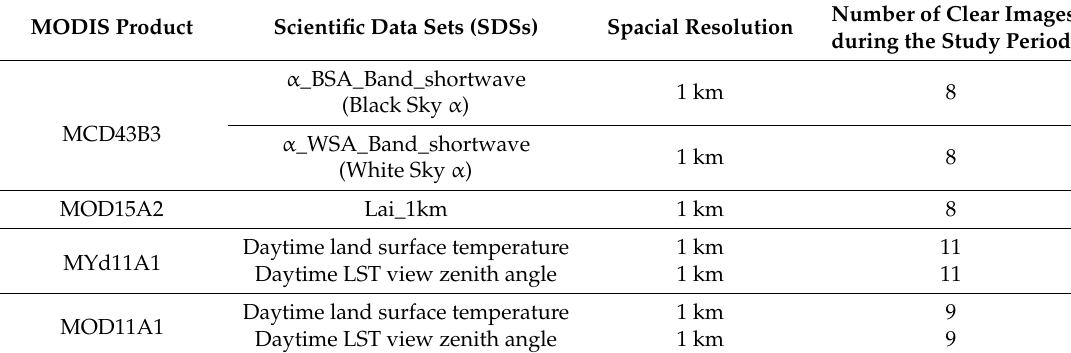
Table 2. List of MODIS products selected as input for the TSEB